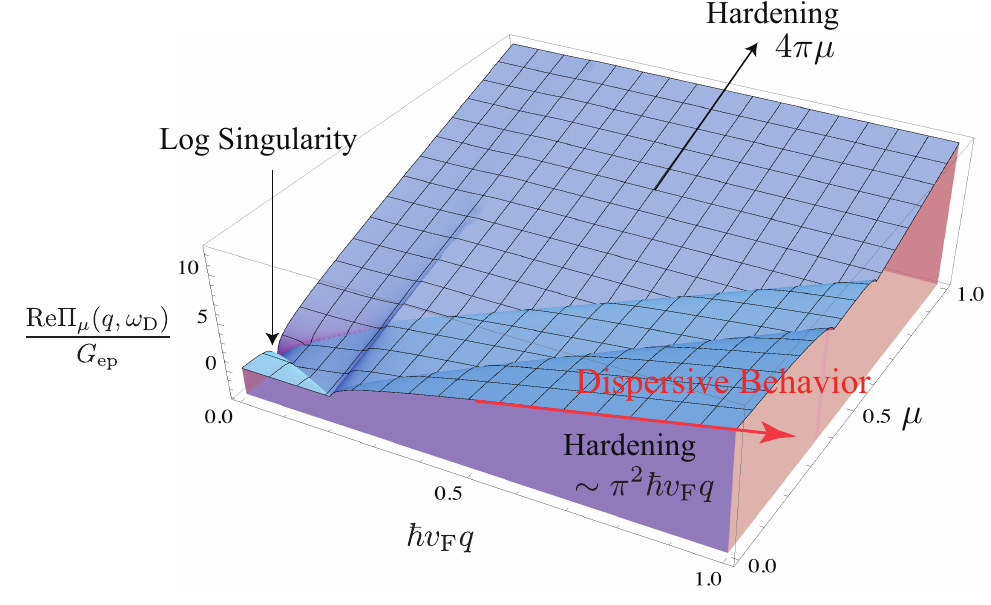
Figure 6. A 3d plot of ReΠ ReΠ ( q, ω ) does not include the q dependence of the bare (cid:22)